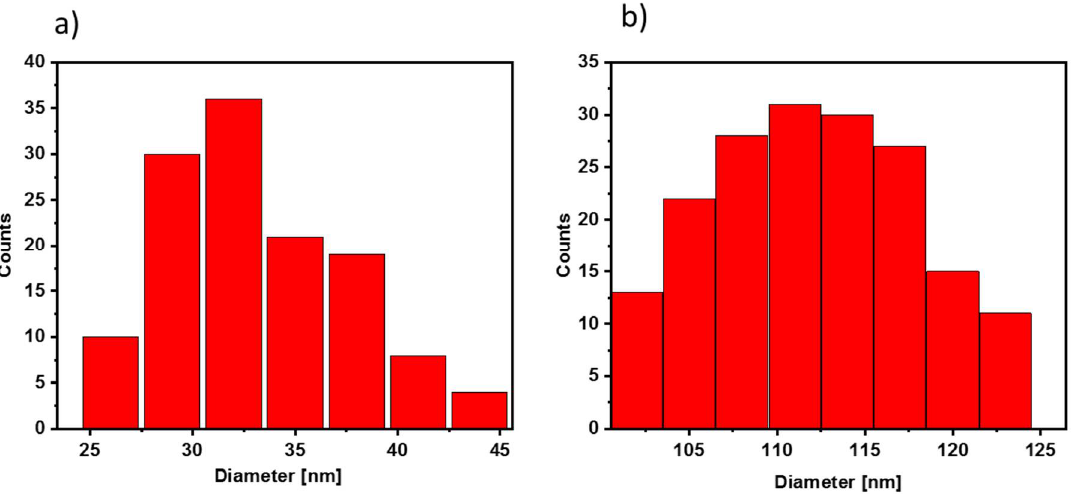
Figure 3. Size distribution graph (data from DLS measurement) of ( a ) IONPs@CA and ( b ) IONPs@CA_GMP_Tb 3+.